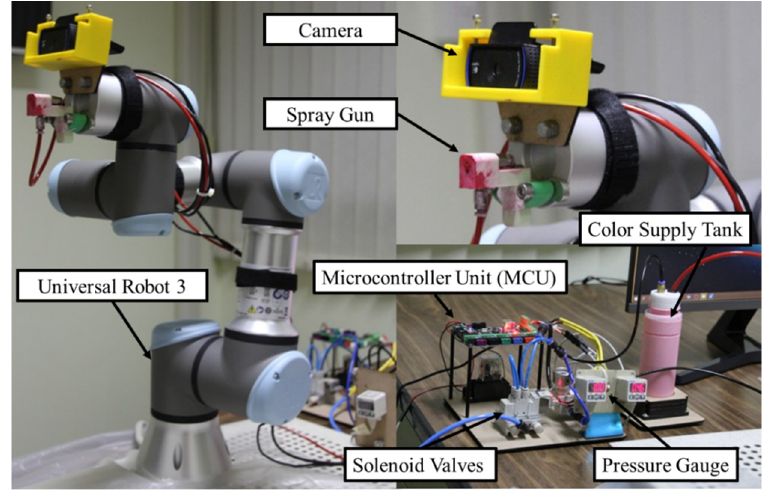
Figure 4. The Components of the Collaborative Painting Robot. The collaborative robot, a 6-DOF manipulator robot, belongs to the UR family of Universal Robots [45]. The controller software of the collaborative robot is Universal Robots 3.15. The workspace of the collaborative robot for the painting application is shown in Figure 5. The red area is the applicable workspace.